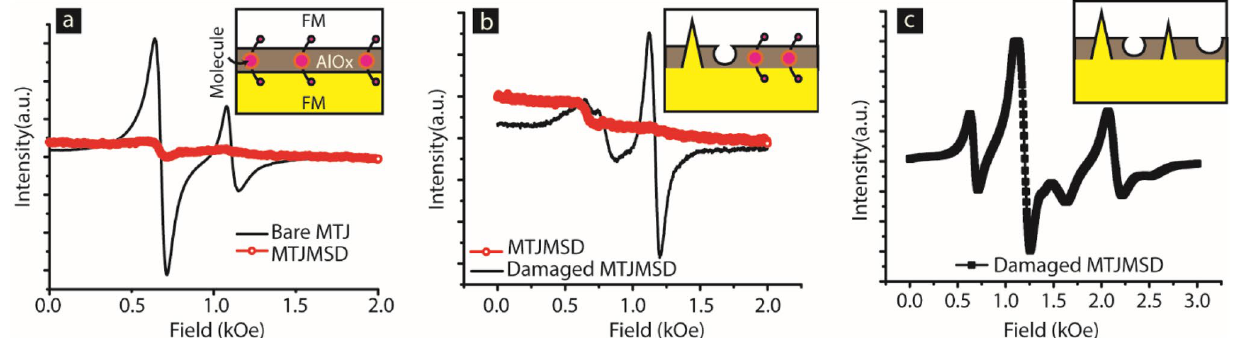
Figure 3. FMR experiment monitoring the position and intensity of modes on a ( a ) good MTJ sample transforming into stable MTJMSD, ( b ) a good MTJMSD failed under mechanical stress, and ( c ) an exemplary MTJ with damaged tunneling barrier. FMR data in panel ( a ), ( b ), and ( c ) were plotted in Originlab ® 2016 softawre. Inset sketches in each panel is drawn in Adobe Illustrator CS6 ® . All the components were assembled and labelled in Adobe Illustrator CS6 ®